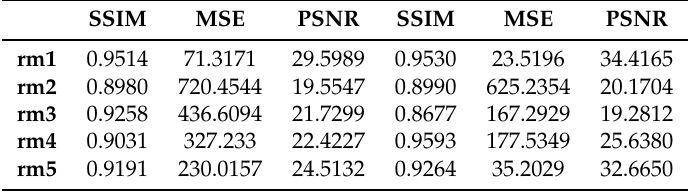
Table 2. CRF test in different datasets.